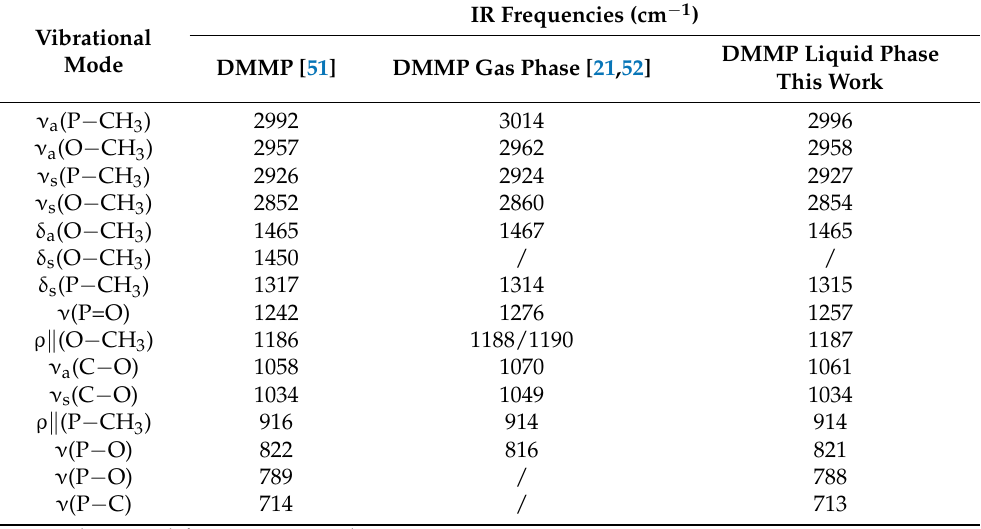
Table 6. Assignments of IR frequencies in